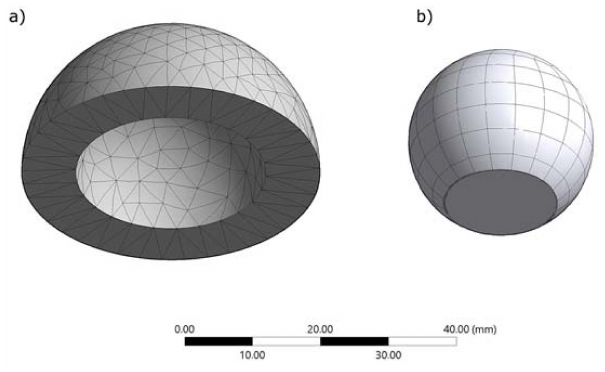
Figure 2. Meshing on ( a ) the acetabular cup and the ( b ) femoral head.